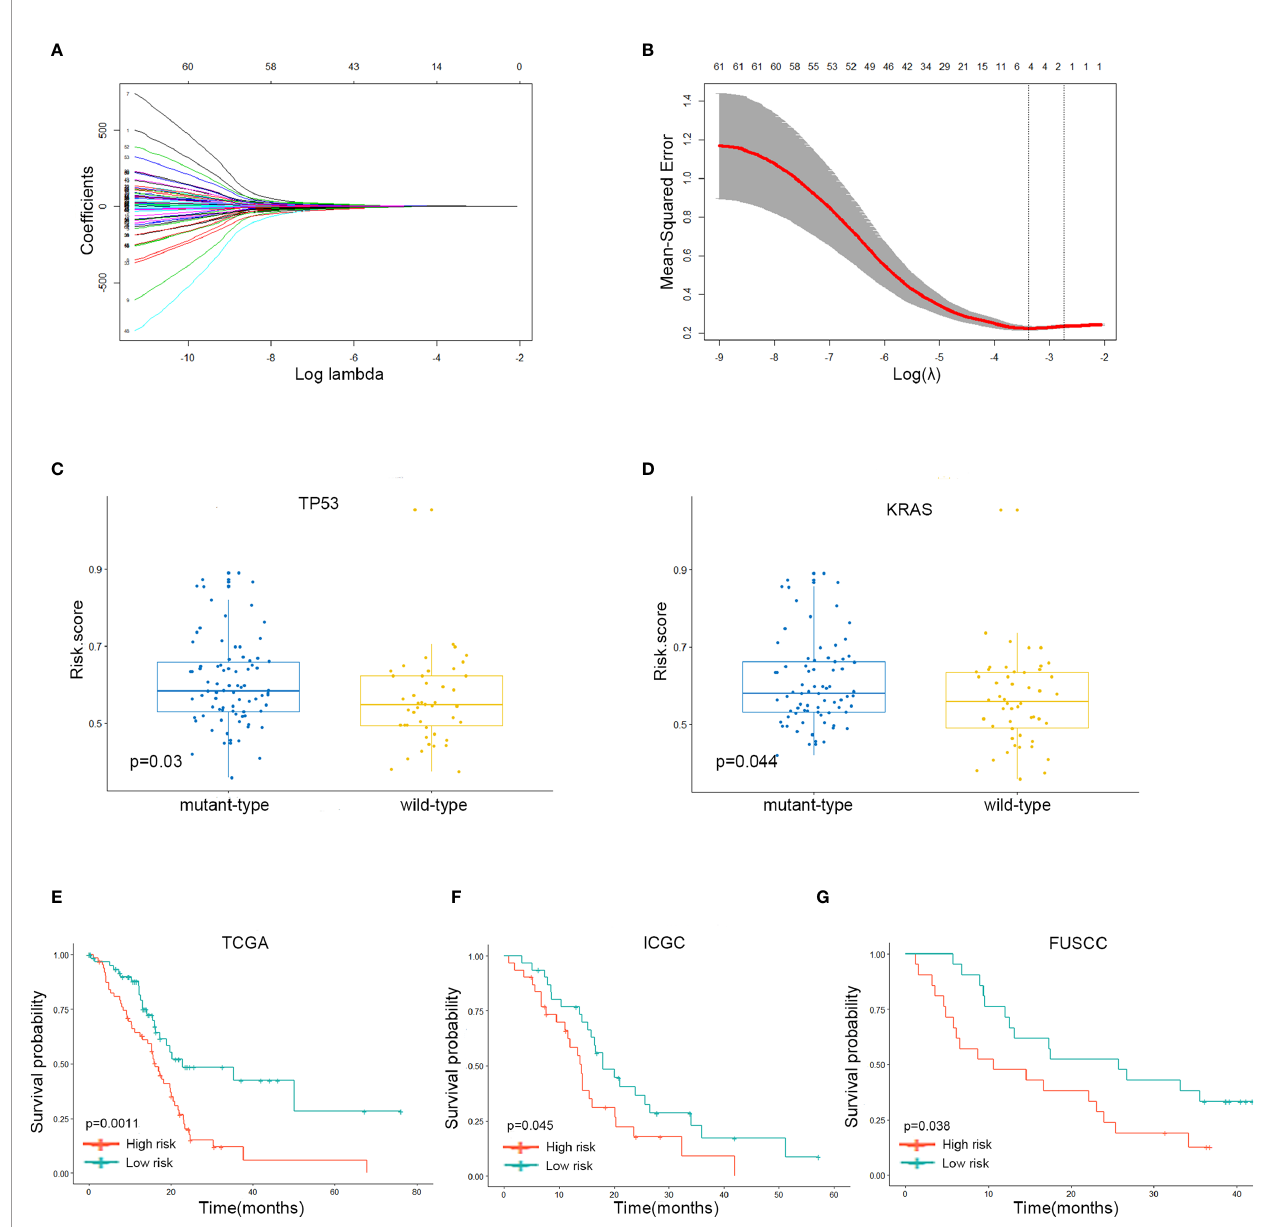
FIGURE 5 | A four-gene signature system was established to predict the overall survival of Stages III and IV PDAC patients in the TCGA discovery and two independent validation cohorts. (A, B) LASSO coef fi cient pro fi les of the 62 immune-related ’ genes. LASSO, least absolute shrinkage and selection operator method. (C) The expression level of the risk score in mutation status of TP53 in Stages III and IV PDAC patients of TCGA dataset. (D) The expression level of the risk score in mutation status of KRAS in Stages III and IV PDAC patients of TCGA dataset. (E) The Kaplan – Meier plot of 5-year overall survival in TCGA Stages III and IV PDAC cohort. (F) The Kaplan – Meier plot of 5-year overall survival in ICGC Stages III and IV PDAC cohort. (G) The Kaplan – Meier plot of 5-year overall survival in FUSCC Stages III and IV PDAC